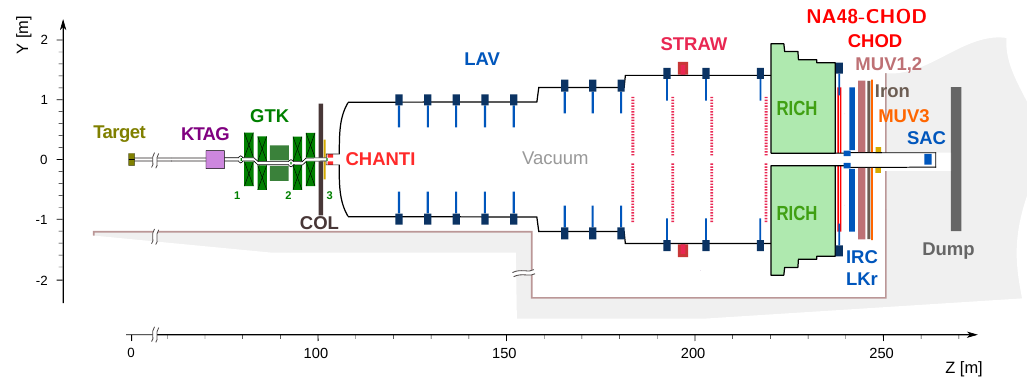
Figure 1. Schematic side view of the NA62 beamline and